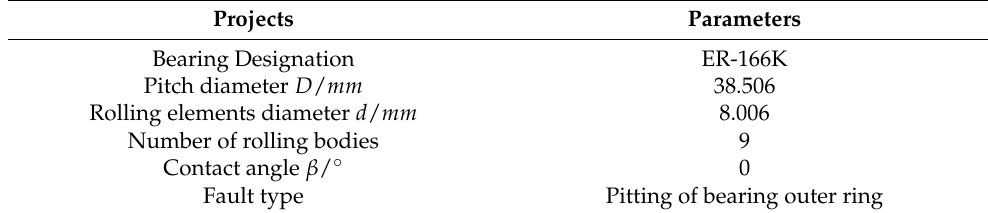
Figure 15. Sensor measuring point location. Table 7. Test bearing specific parameters.